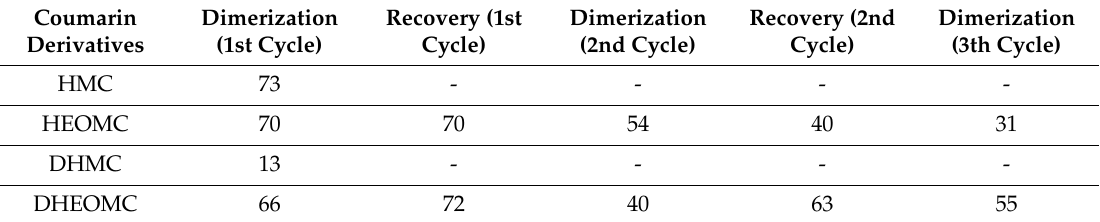
Table 1. Dimerization and cleavage conversions of coumarin